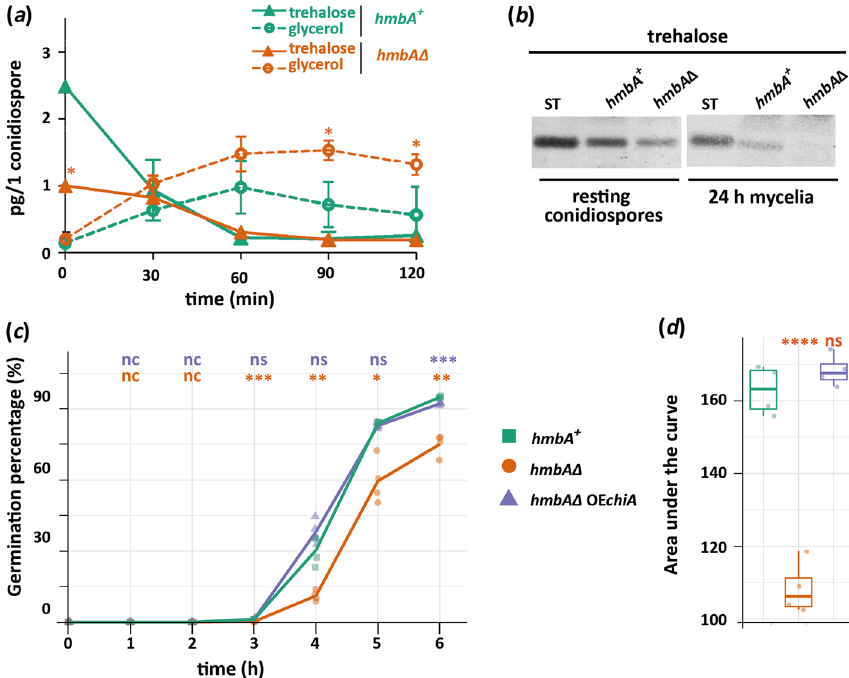
Figure 7. Comparison of trehalose content and metabolism of trehalose to glycerol in hmbAΔ and hmbA + conidiospores and characterization of conidiospore germination. ( a ) HPLC-detected conversion of trehalose to glycerol during the first two hours of germination in hmbAΔ and hmbA + conidiospores. Measurements started with the analysis of resting conidiospores at the 0 h time point. Colour and figure codes are shown in the figure legend. Mean of three biological replicates are shown. Error bars represent standard deviation. Significant differences (Student’s t -test) are marked with asterisks (* P < 0.05); ( b ) Detection of trehalose by TLC in conidiospores and mycelia of hmbAΔ and hmbA + strains. ST indicates trehalose standard. ( c ) Characterization